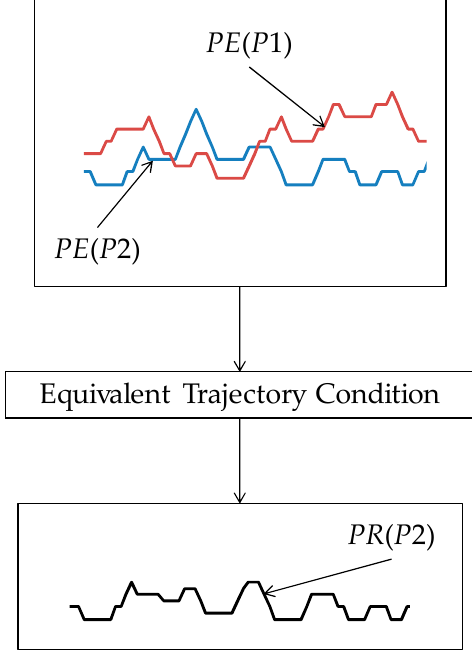
Figure 7. Creating resultant trajectory for two passes.